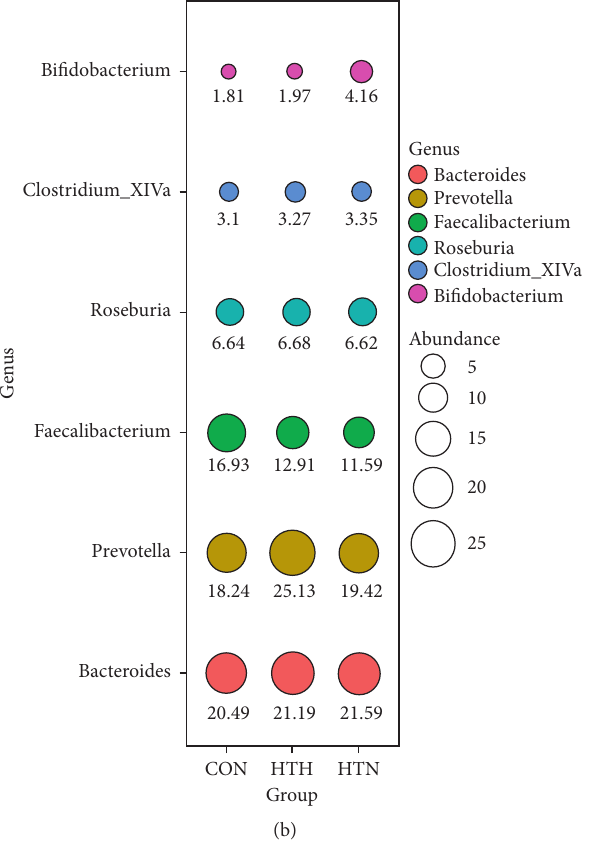
Figure 2: Differences in bacterial taxa abundance among the three groups at phylum and genus levels. The relative abundance of major OTUs expressed in different colors among the three groups was indicated by bubble plot, where the abundance is scaled by bubble area and indicated by number in